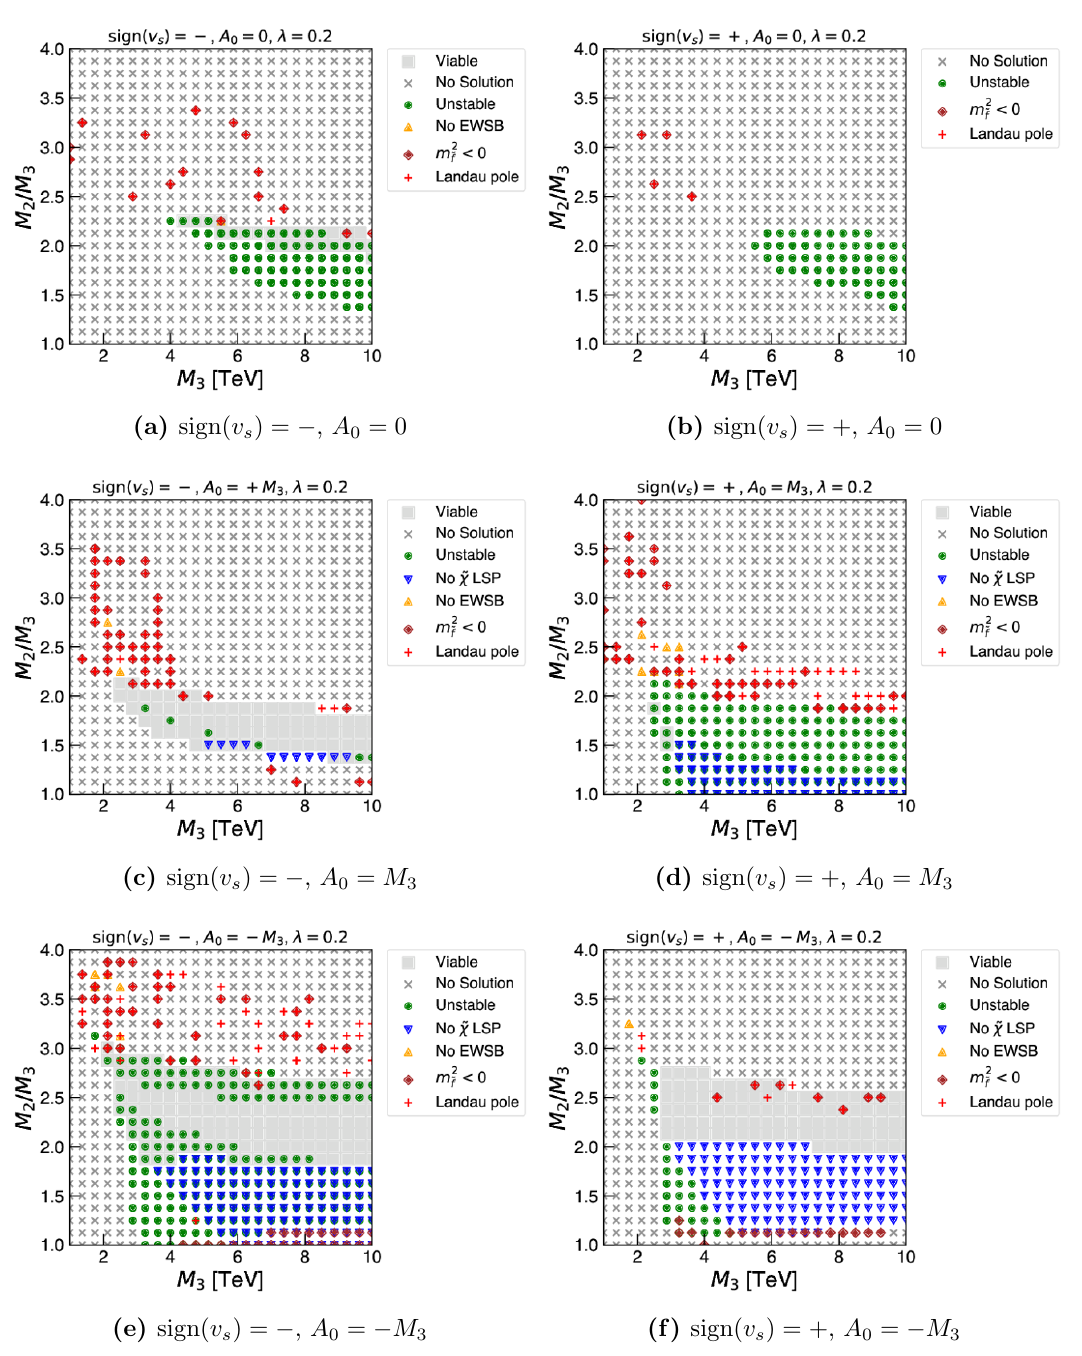
Figure 2. Viable/excluded parameter points in the M 3 - M 2 =M 3 plane for each choice of sign( v s ) and A 0 . Here we set m 0 = 1 TeV and (cid:21) = 0 : 2, and determine tan (cid:12) from the universality condition m 2 = m 2 0 S